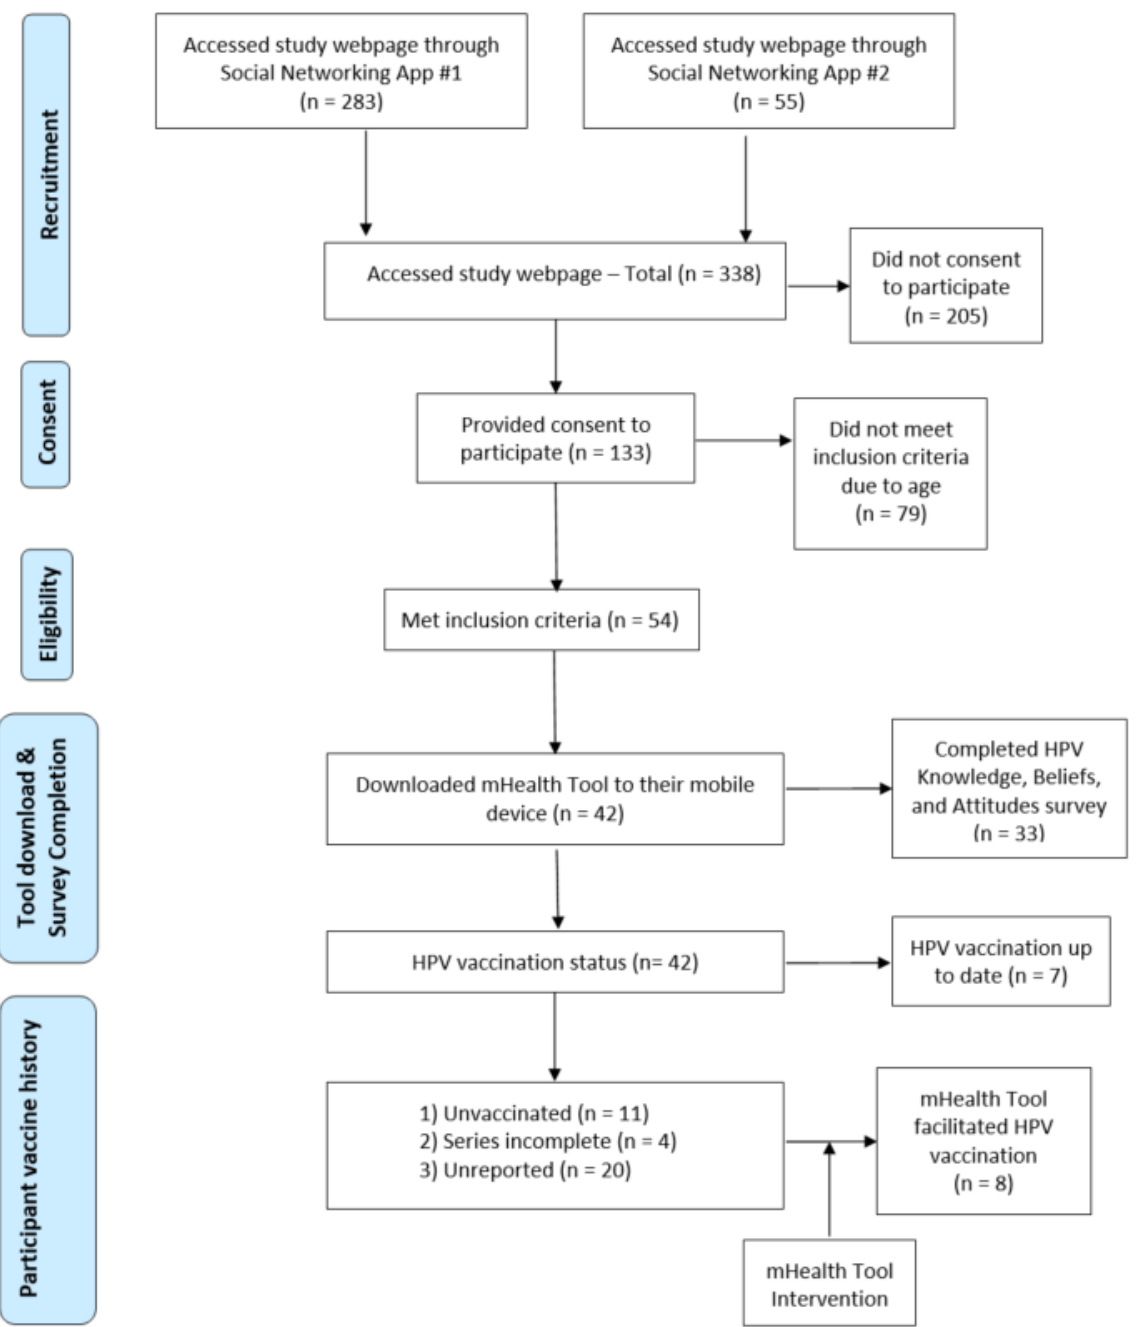
Figure 1. Participant progression though study protocol. HPV: human papillomavirus; mobile health: